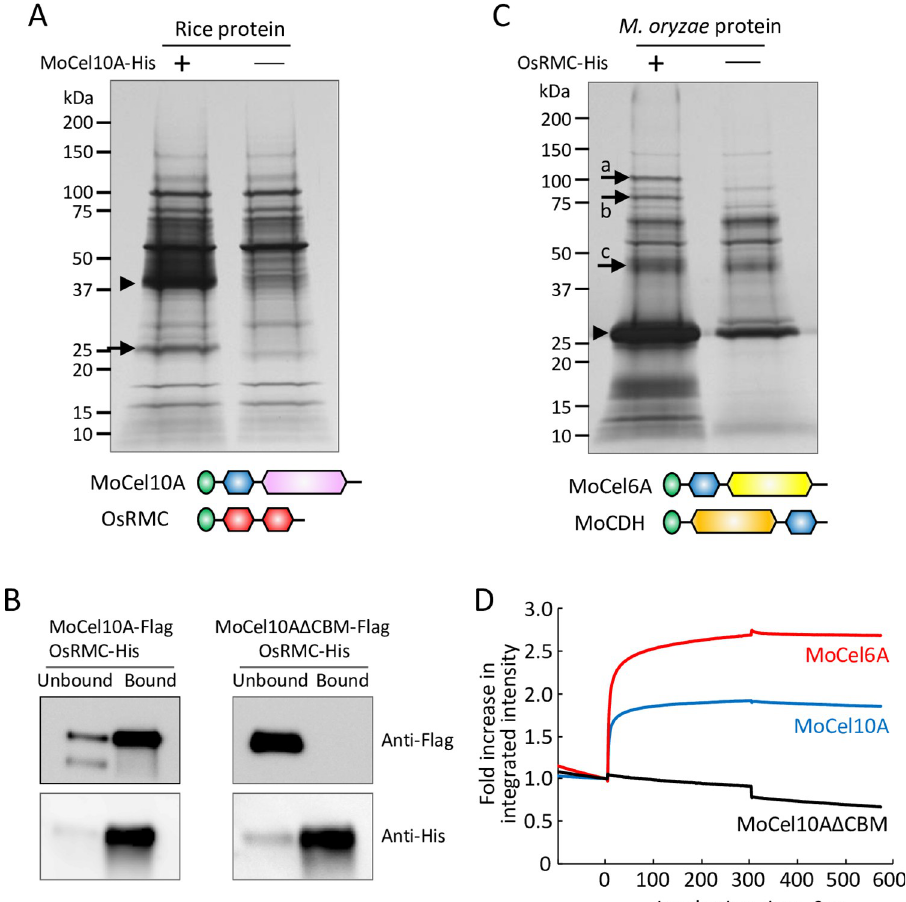
Fig 1. OsRMC binds to CBM1 of fungal enzymes. (A) Protein extract from rice leaves 4 days after inoculation with M . oryzae (Ken53-33) was incubated with (+) or without (-) MoCel10A-His in the presence of His-resin. Fractions bound to His-resin were subjected to SDS-PAGE followed by silver staining. Arrowhead indicates MoCel10A-His. The protein band indicated by an arrow was identified by LC-MS/MS. Schematic structures of predicted full-length proteins of MoCel10A and OsRMC are shown: green, secretion signal peptide; blue, CBM1 (PF00734); pink, GH10 catalytic core domain (PF00331); red, DUF26 domain (PF01657). (B) OsRMC-His mixed with MoCel10A-Flag or MoCel10A Δ CBM-Flag was applied to His-resin. Fractions unbound and bound to His-resin were subjected to SDS-PAGE followed by immunoblot analysis using anti-Flag and anti-His antibodies. (C) Culture filtrate from M . oryzae hyphae liquid culture was incubated with (+) or without (-) OsRMC-His in the presence of His-resin. Fractions bound to His-resin were subjected to SDS-PAGE followed by silver staining. Arrowhead and arrows indicate OsRMC-His and candidate proteins bound to OsRMC-His, respectively. Schematic structures of MoCel6A and OsCDH are shown: green, secretion signal peptide; blue, CBM1 (PF00734); yellow, GH6 catalytic core domain (PF01341); orange, CDH-cyt domain (PF16010). (D) Integrated intensity representing the binding kinetics of OsRMC to MoCel10A, MoCel6A, and MoCel10A Δ CBM. Association of MoCel10A, MoCel6A, and MoCel10A Δ CBM (10 μ L, 2.0 μ M) with OsRMC was measured from time 0 to 300 s. Binding buffer was used to measure protein dissociation from time 300 to 570 s. Fold increase in integrated intensity was calculated by dividing each trajectory by the value at time zero. Each curve is representative of three assays. Binding kinetic values were determined by calculating means ± SD of three independent